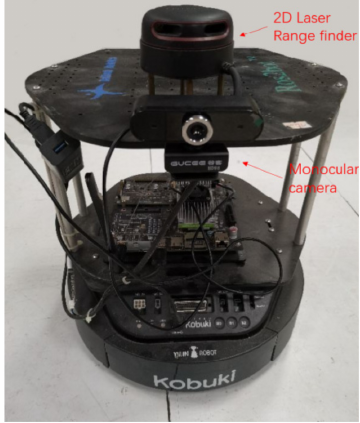
Figure 8. The mobile robot